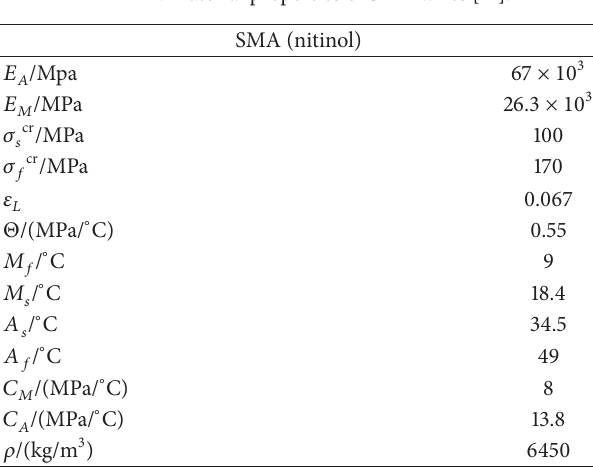
Table 2: Material properties of SMA wires